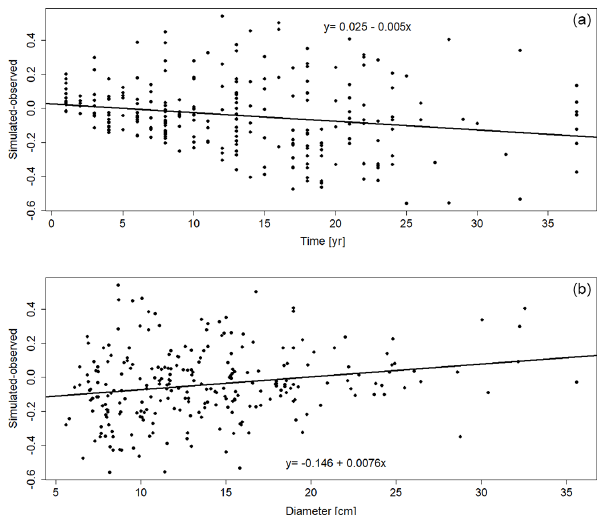
Figure 8. Residual analysis between simulated and observed carbon remnants of wood decomposition from Mäkinen et al. (2006) on (a) decomposition time and (b)